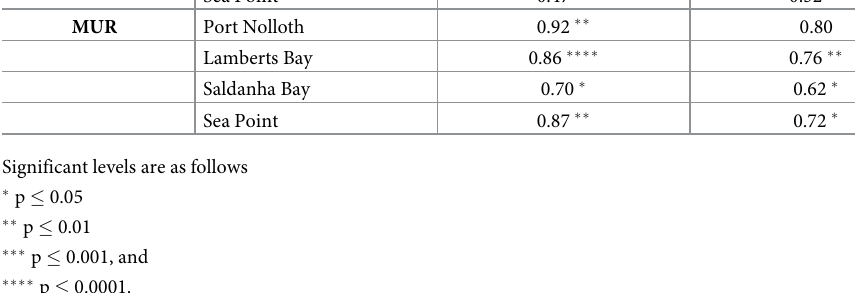
Significant levels are as follows �